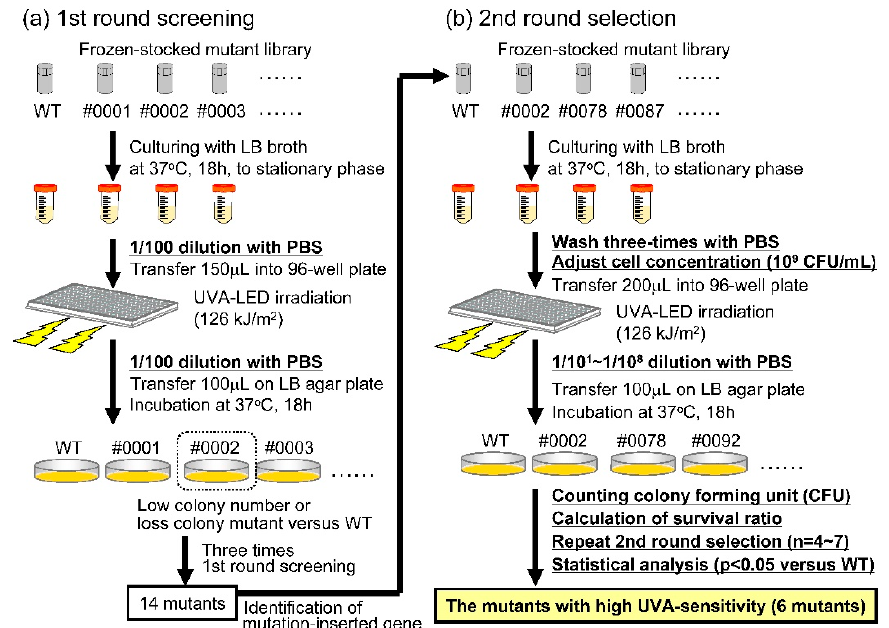
Figure 1. Selection of highly UVA-sensitive mutants from a V. parahaemolyticus transposon-mutant library. Highly UVA-sensitive mutants were separated from the mutant library by a two-step screening process. ( a ) First-round screening as shown. The bacterial cell numbers in each of the samples were not adjusted prior to UVA irradiation and the number of colony-forming units (CFUs) detected after culture of the UVA-irradiated samples was not determined. ( b ) Second-round screening. The bacterial cell concentrations were adjusted to 10 9 CFU/mL prior to UVA irradiation; CFUs in each sample both with or without UVA irradiation were counted.